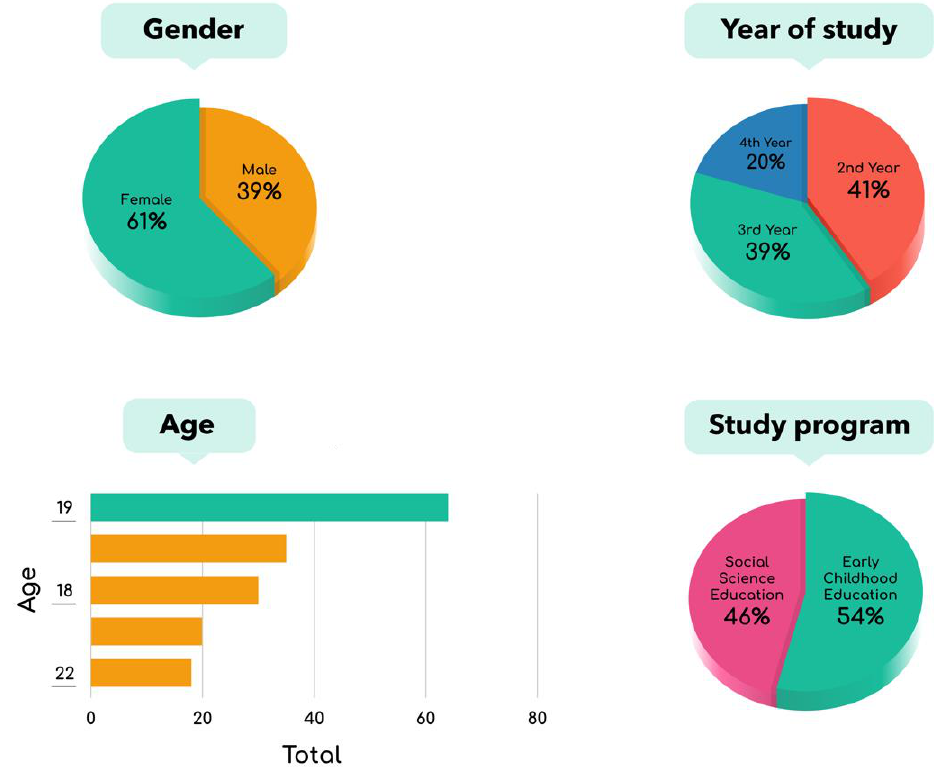
Figure 1. Demographic profile of the study participants.